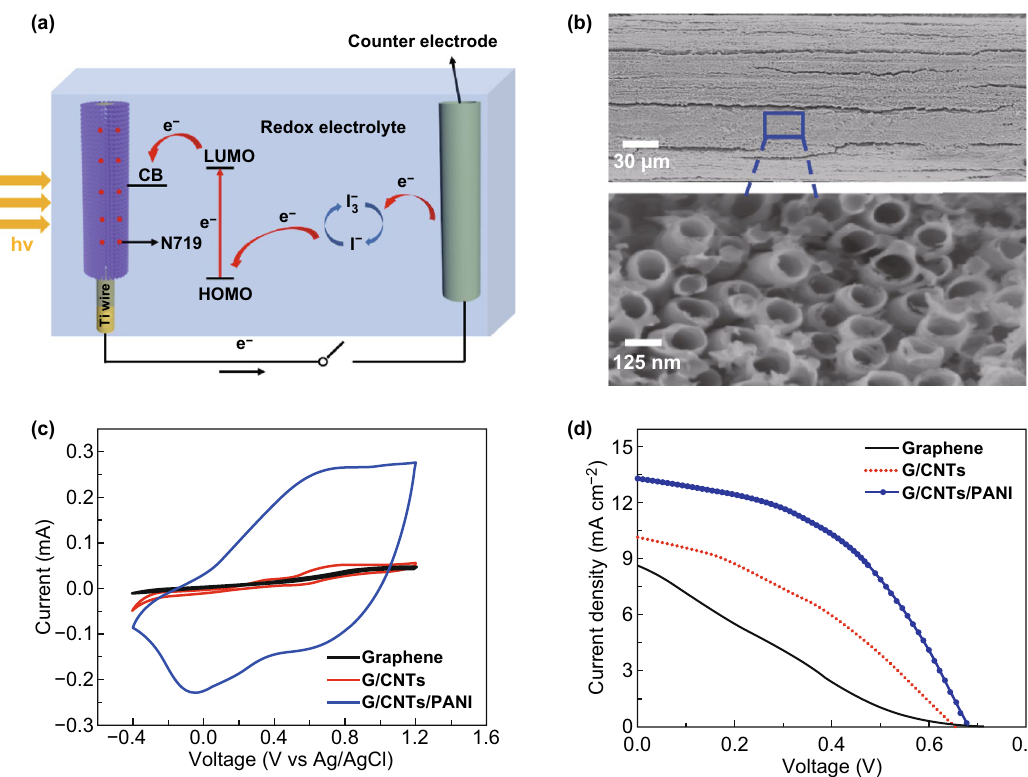
Fig. 4 a Schematic working principle of fiber-shaped DSSC. b SEM image of a Ti wire grown with TiO 2 nanotubes by electrochemical anodi- zation for 2 h. c CV curves of graphene, G/CNTs and G/CNTs/PANI fibers in I - /I 3- electrolyte at scan rate of 50 mV s −1 . d Current density–volt- age ( J – V ) curves of DSSCs by using graphene, G/CNTs, and G/CNTs/PANI fibers as the counter